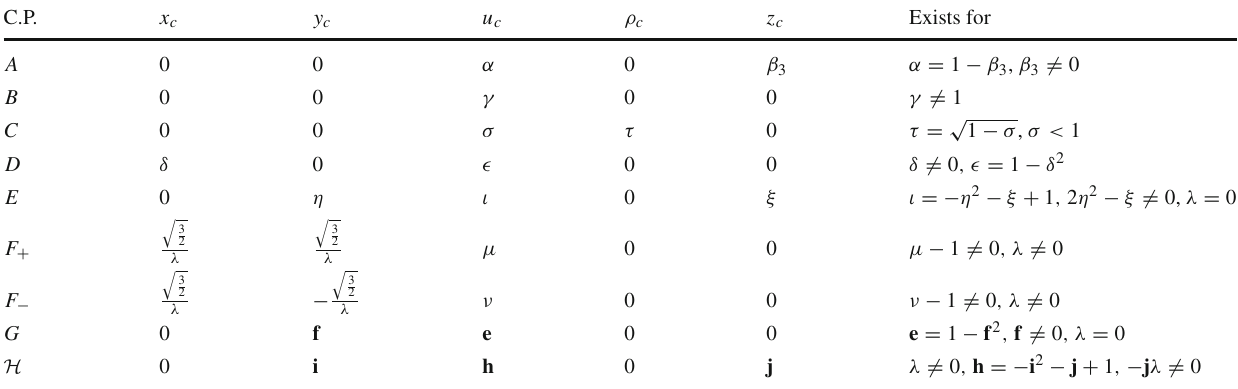
Table 1 Critical points for the dynamical system C.P.